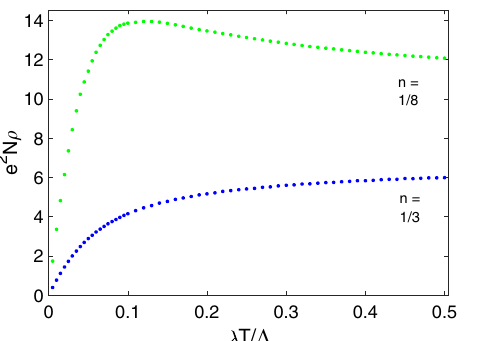
Fig. 1 Resistivity per fl avor, in units of 1/ e 2 N , as a function of λ T / Λ in the N → ∞ limit, where Λ is the bandwidth, for a two-dimensional square lattice. The blue and green curves are, respectively, for a density per site in each fl avor, n = 1/3 and n = 1/8. At the lower density, the resistivity exceeds the saturating value and then approaches it with increasing temperature from